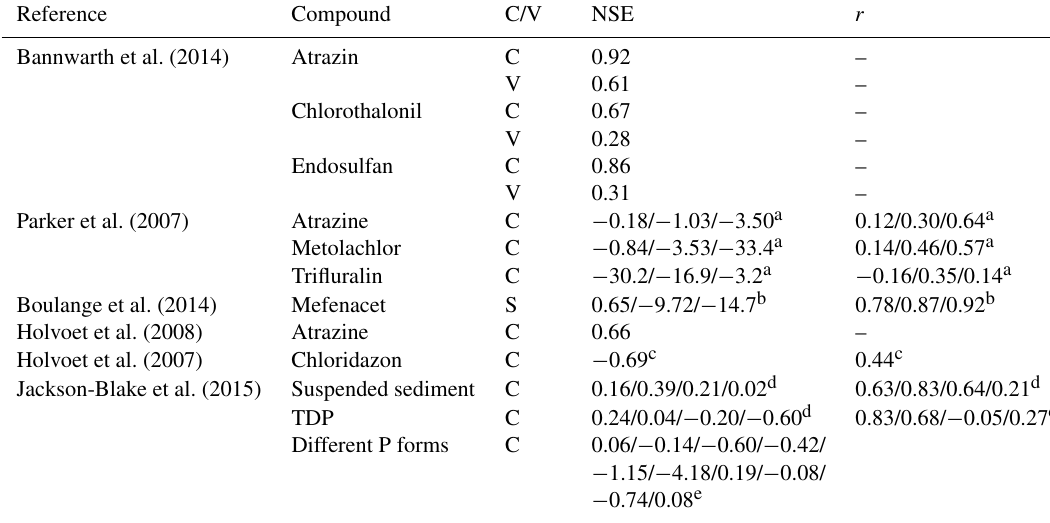
a Values for three different models. b Values for three different model parameter sets. c NSE and r calculated from data points derived from Fig. 3 of the reference. d Values for four different river reaches (Table 3 of the reference). e Values taken from Table 5 of the reference for diffuse P